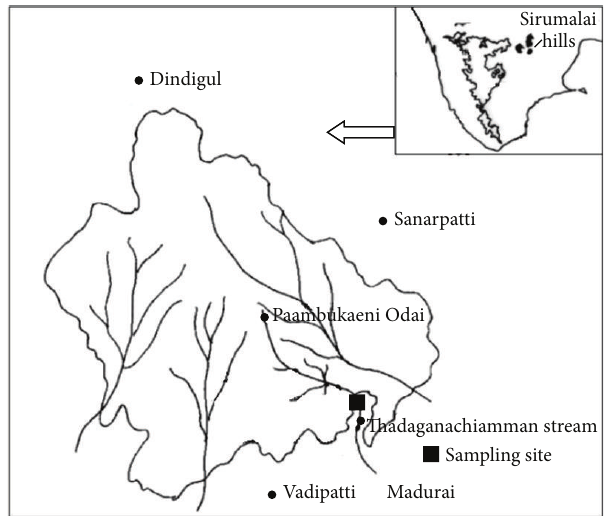
Figure 1: Study area—Siurmalai hills, southern